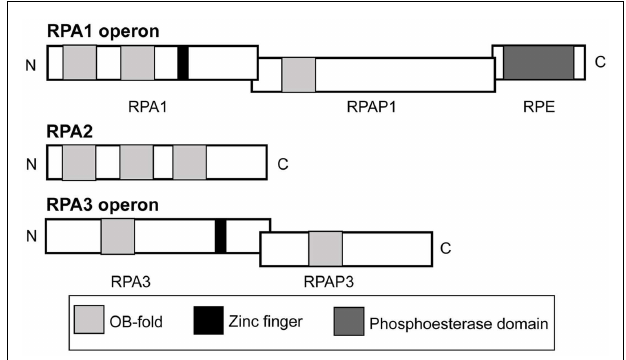
FIGURE 1 | Operon and domain structures of H. volcanii single-stranded DNA-binding proteins. Genes for RPA1 and RPA3 are in operons with genes for RPA-associated proteins, RPAP1 and RPAP3, respectively.The gene for RPA1 phosphoesterase (RPE) is present in the rpa1 operon. Domains (not to scale) comprising OB-folds, zinc fingers and a phosphoesterase motif are